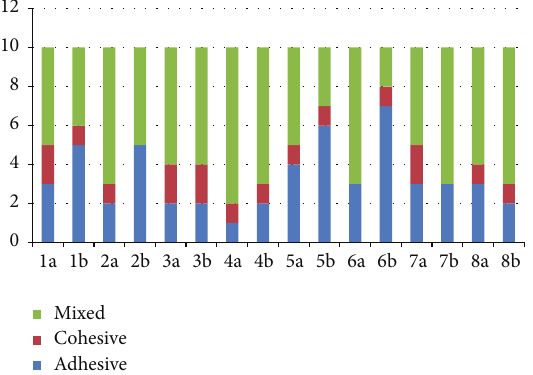
Figure 1: Failure modes in different experimental